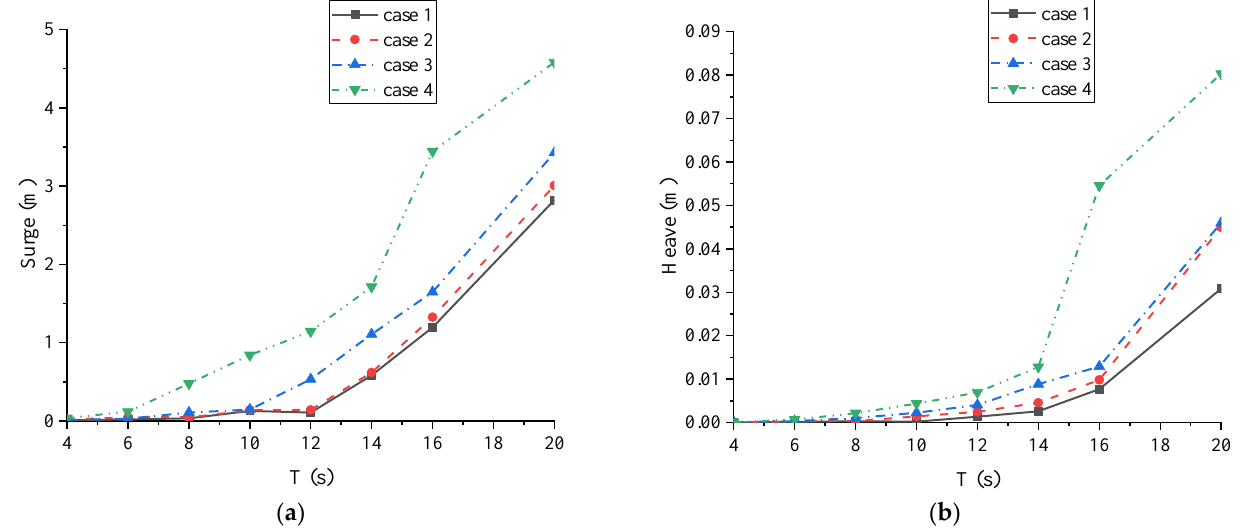
Figure 11. Main motion responses of the first head-wave hexagonal module under different layouts: ( a ) surge; ( b ) heave.